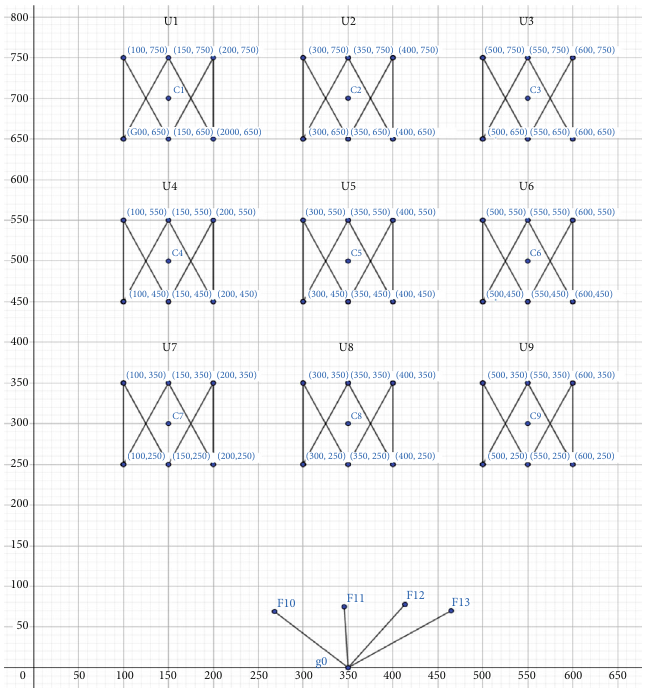
Figure 6: Search and rescue scene.